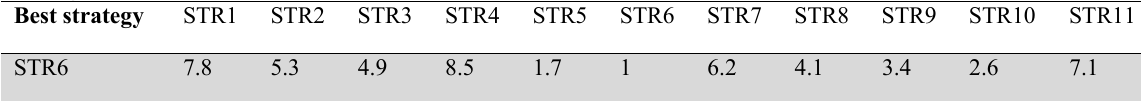
Strategies of BO Vector Best strategy